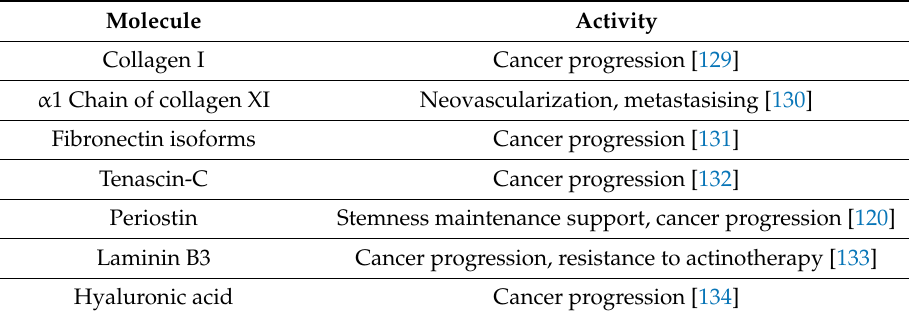
Table 1. Examples of ECM bioactive molecules supporting growth of